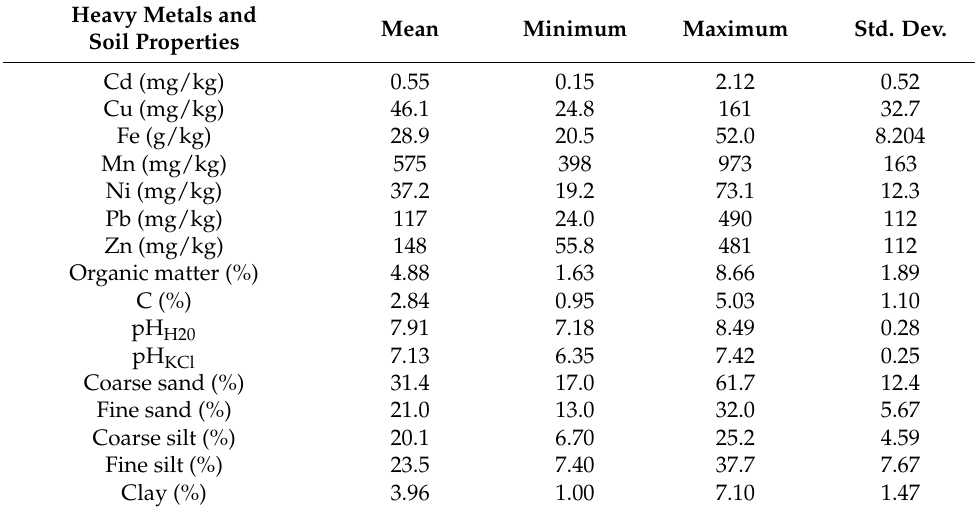
Table 1. Descriptive statistics of heavy metal content in soil samples and soil properties of studied sites of urban grassland in the city of Varaždin (N